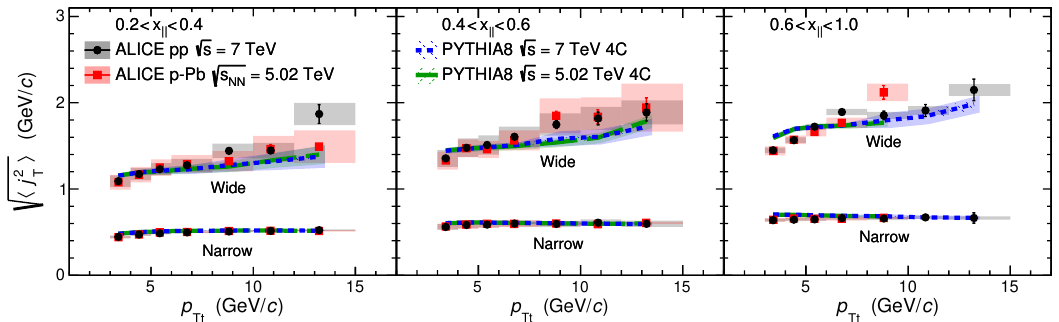
Figure 4 . RMS values of the narrow and wide j T components. Results from pp collisions at p s = 7 TeV (circular symbols) and from p{Pb collisions at compared to Pythia 8 tune 4C simulations at (long dashed line). Di(cid:11)erent panels correspond to di(cid:11)erent x 0 : 4 < x < 0 : 6 in the middle, and 0 : 6 < x k by bars and the systematic errors by